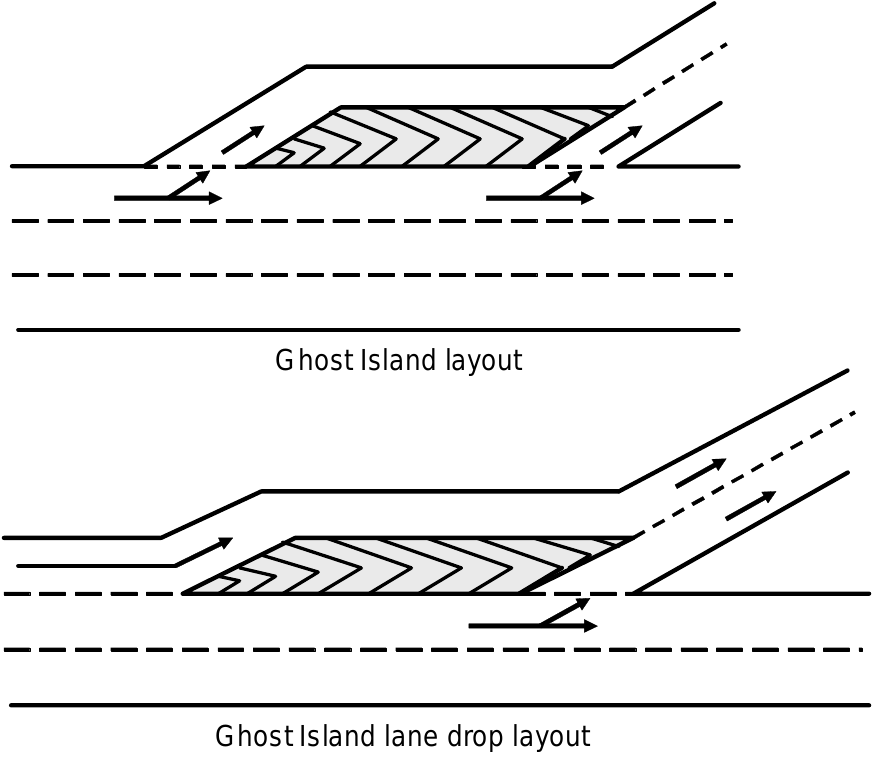
Figure 6. Schematic diagram showing the Ghost Island diverge